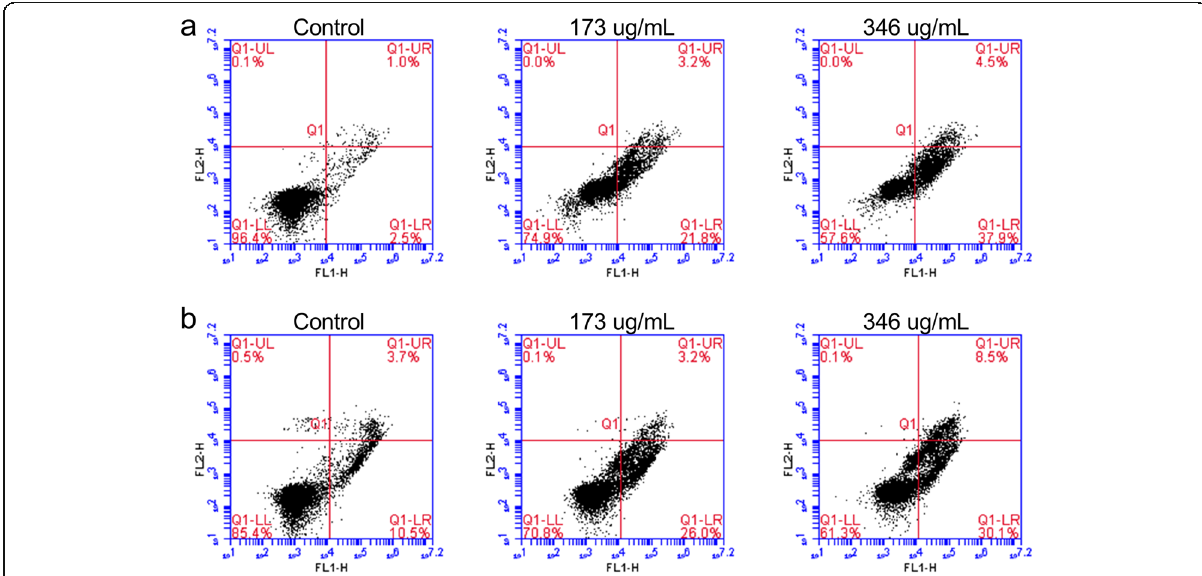
Fig. 4 The quantitative assessment of apoptosis induced by AELE using Annexin V/PI. Monomac-1 ( a ) and KG-1 ( b ) were treated with the two concentrations of AELE within which the IC50 falls (173 and 346 μ g/mL), followed by staining with Annexin V/PI, and analysis using flow cytometry. A shift from double-negative staining, to Annexin V-positive and PI-negative staining, an early apoptotic marker, upon treatment with AELE was observed. A slight increase in double positive stained cells was also